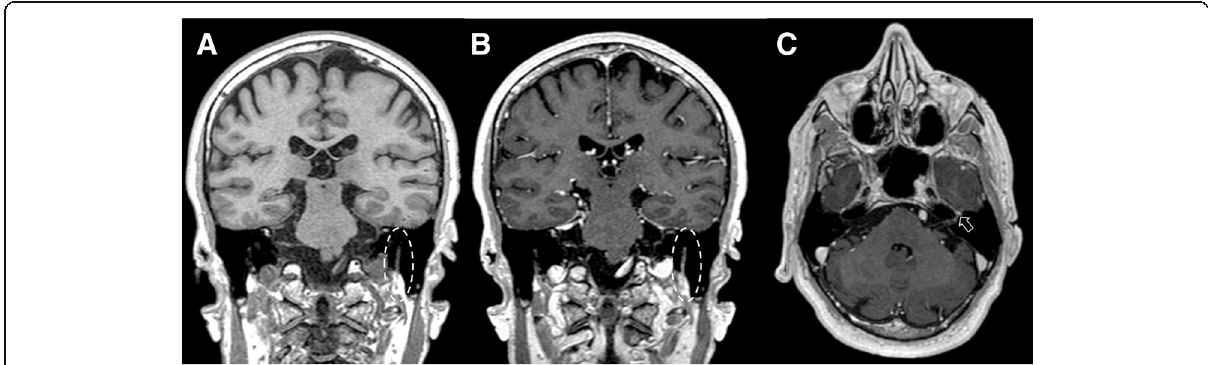
Fig. 26 Bell ’ s Palsy. MRI T1-weighted pre- ( a ) and post-gadolinium ( b ), coronal images; T1-weighted post-contrast axial image ( c ). In a , b , note the swelling and enhancement of the left facial nerve (dotted circles); in c , the enhancement around the geniculate ganglion (arrow)